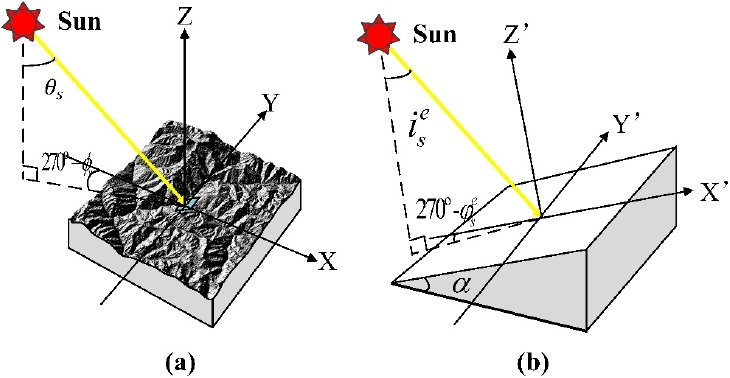
Figure 1. ( a ) Rugged terrain with a large number of subpixel slopes; ( b ) Virtually-smoothed single slope.